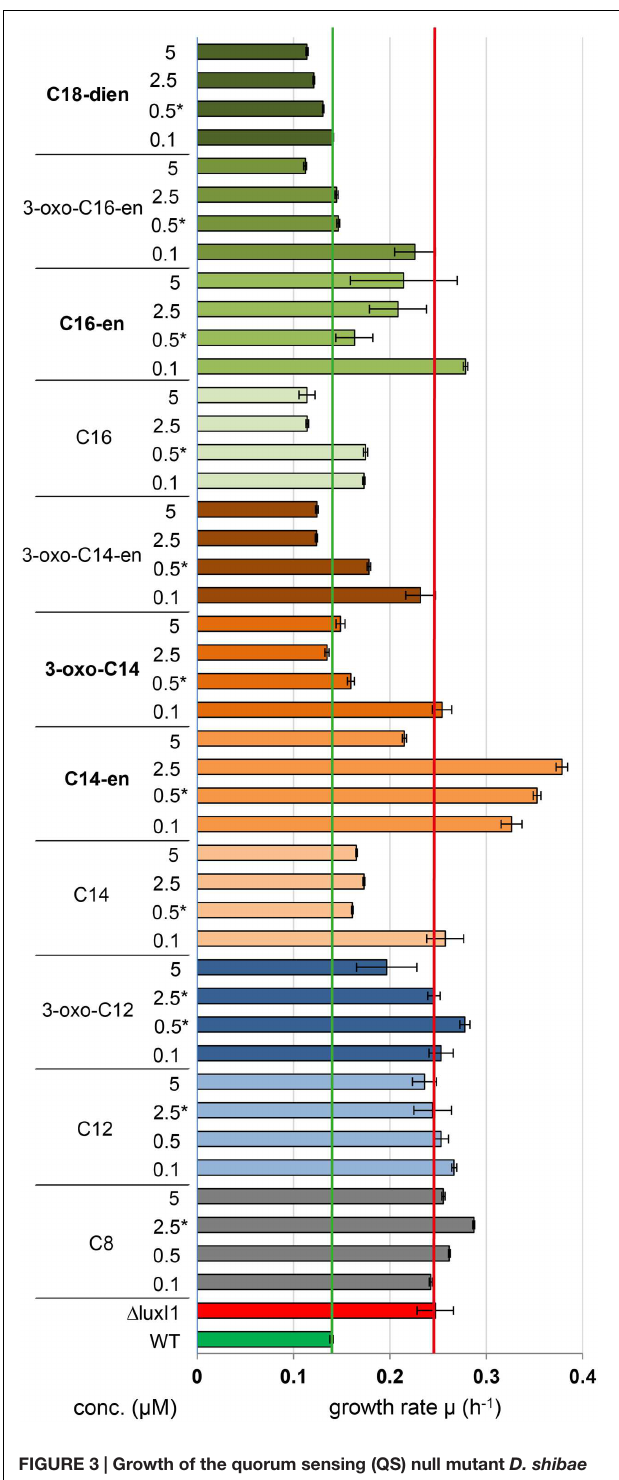
FIGURE 3 | Growth of the quorum sensing (QS) null mutant D. shibae (cid:49) luxI 1 supplemented with external acyl-homoserine lactones AHLs. Indigenous AHLs are shown in bold letters. Data for signal molecules with the same acyl side-chain length are displayed in the same color. Mean and standard deviation for three biological replicates are shown. Vertical lines mark the wild-type (green) and mutant (red) level. Asterisk ( ∗ ) labeled concentrations were used for subsequent